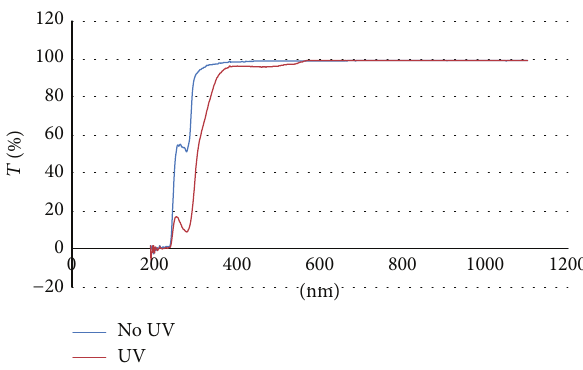
Figure 5: UV-Vis transmittance spectra for irradiated and nonirra- diated gels. The red spectrum is that of the irradiated sample, while the blue spectrum is that of the nonirradiated